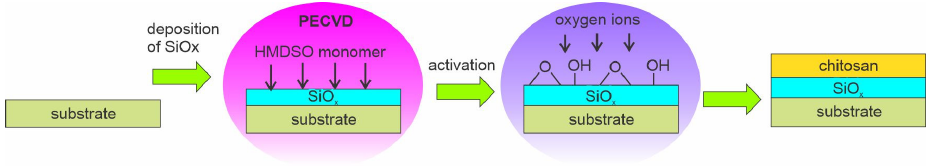
Figure 13. A method for immobilization of a chitosan film using SiO x intermediate layer.